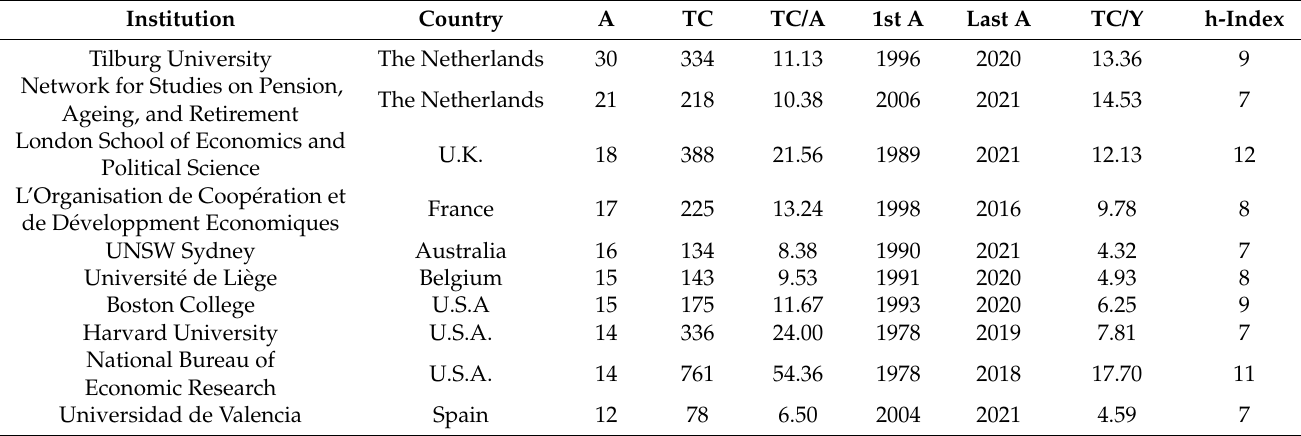
Table 7. The top 10 most productive institutions on pension